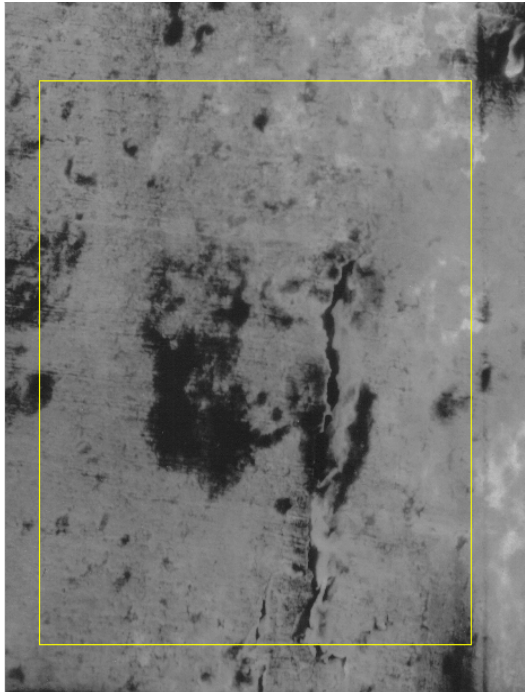
Figure 1. Original image and a selected area.